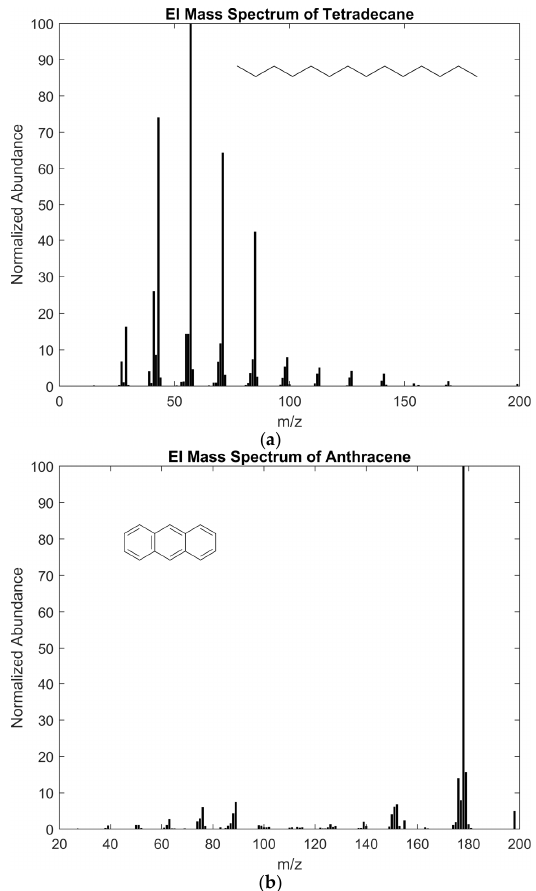
Figure 4. Representative mass spectra from the NIST 11 library for: ( a ) tetradecane (NIST record #229858); and ( b ) anthracene (NIST record #228201).